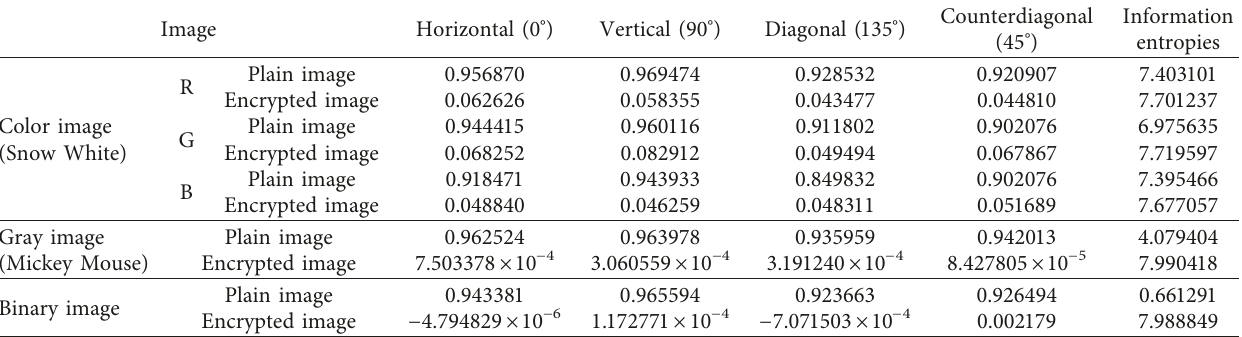
Figure 7: Correlation coefficients of plain and encrypted rectangle image Snow White. Table 1: Correlation coefficients of plain image and encrypted